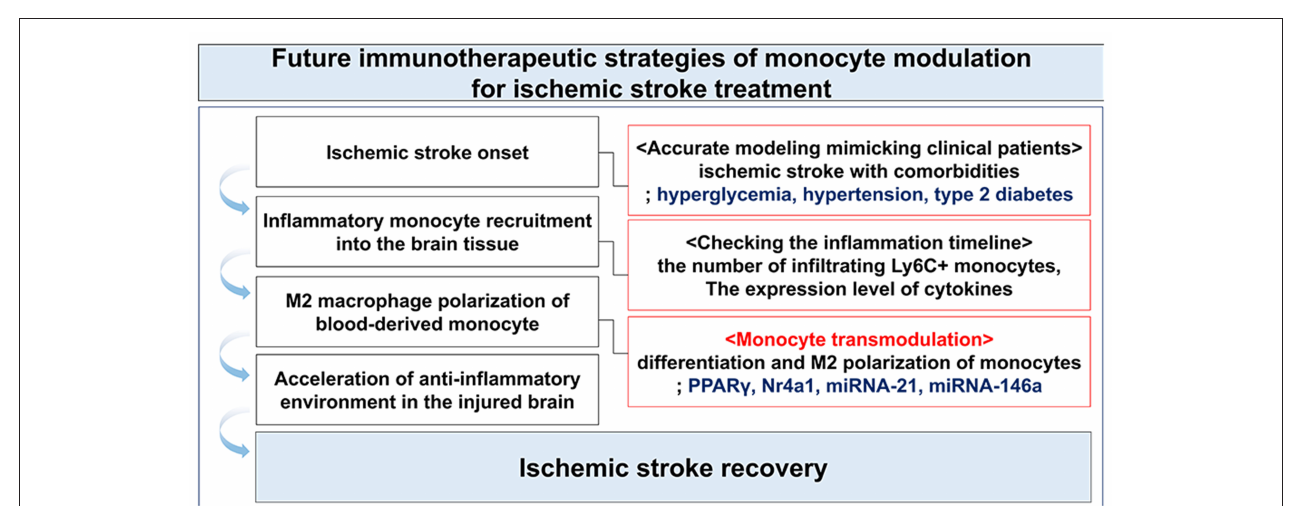
FIGURE 3 | Immunotherapeutic strategy through the modulation of monocytes following ischemic stroke.